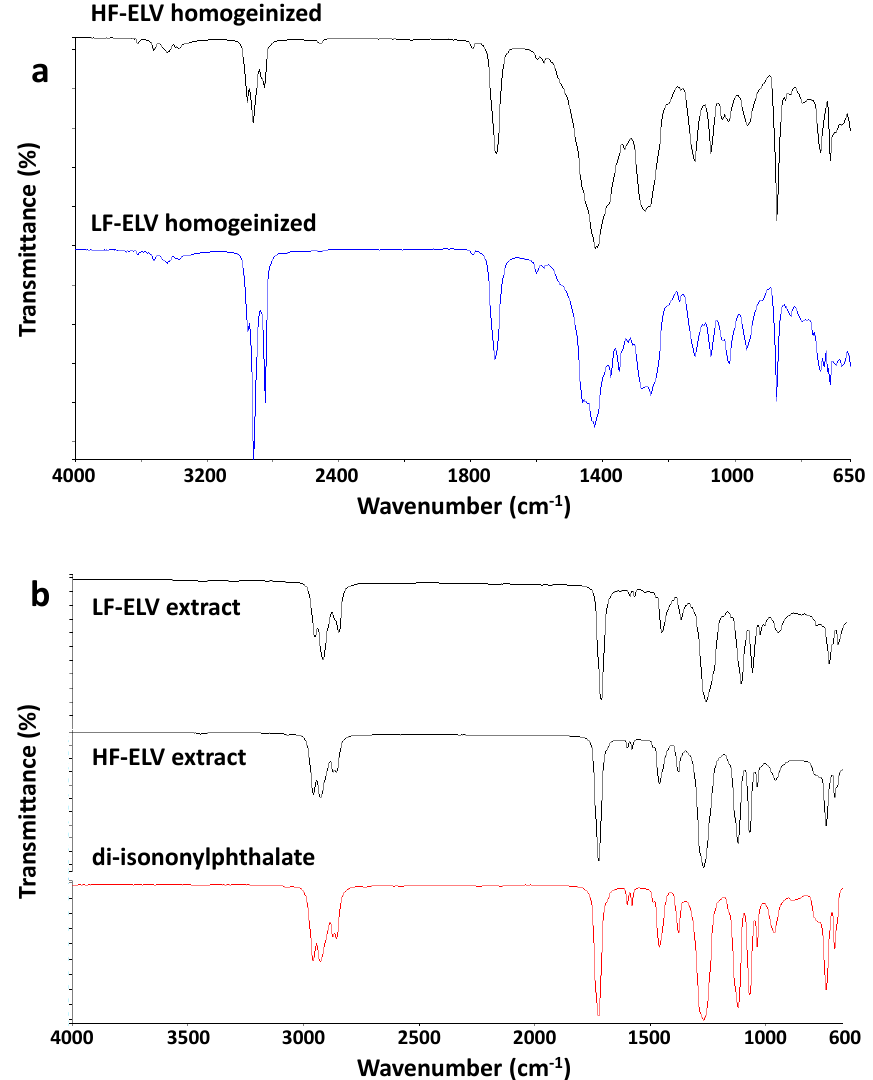
Figure 7. ATR-FTIR spectra of: ( a ) Homogeinized LF-ELV and HF-ELV samples; ( b ) extracts in Figure 7. ATR ‐ FTIR spectra of: ( a ) Homogeinized LF ‐ ELV and HF ‐ ELV samples; ( b ) extracts in chloroform from LF-ELV and HF-ELV samples and di-isononylphthalate reported for chloroform from LF ‐ ELV and HF ‐ ELV samples and di ‐ isononylphthalate reported for comparison.